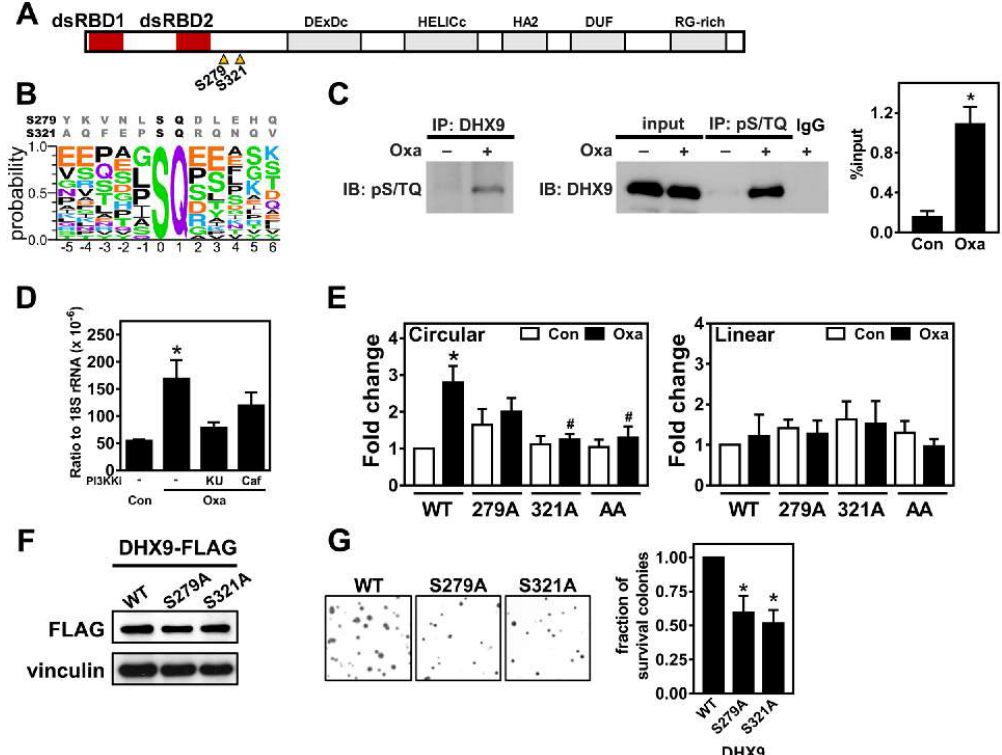
Figure 4. Oxaliplatin-induced DHX9 phosphorylation promotes circRNA expression. ( A ) Illustration of DHX9 domains. Triangles: Potential phosphorylation sites at serine 279 and 321. ( B ) Sequences around predicted PI3KK phosphorylation sites in DHX9 (top) compared to known sequences (Bottom